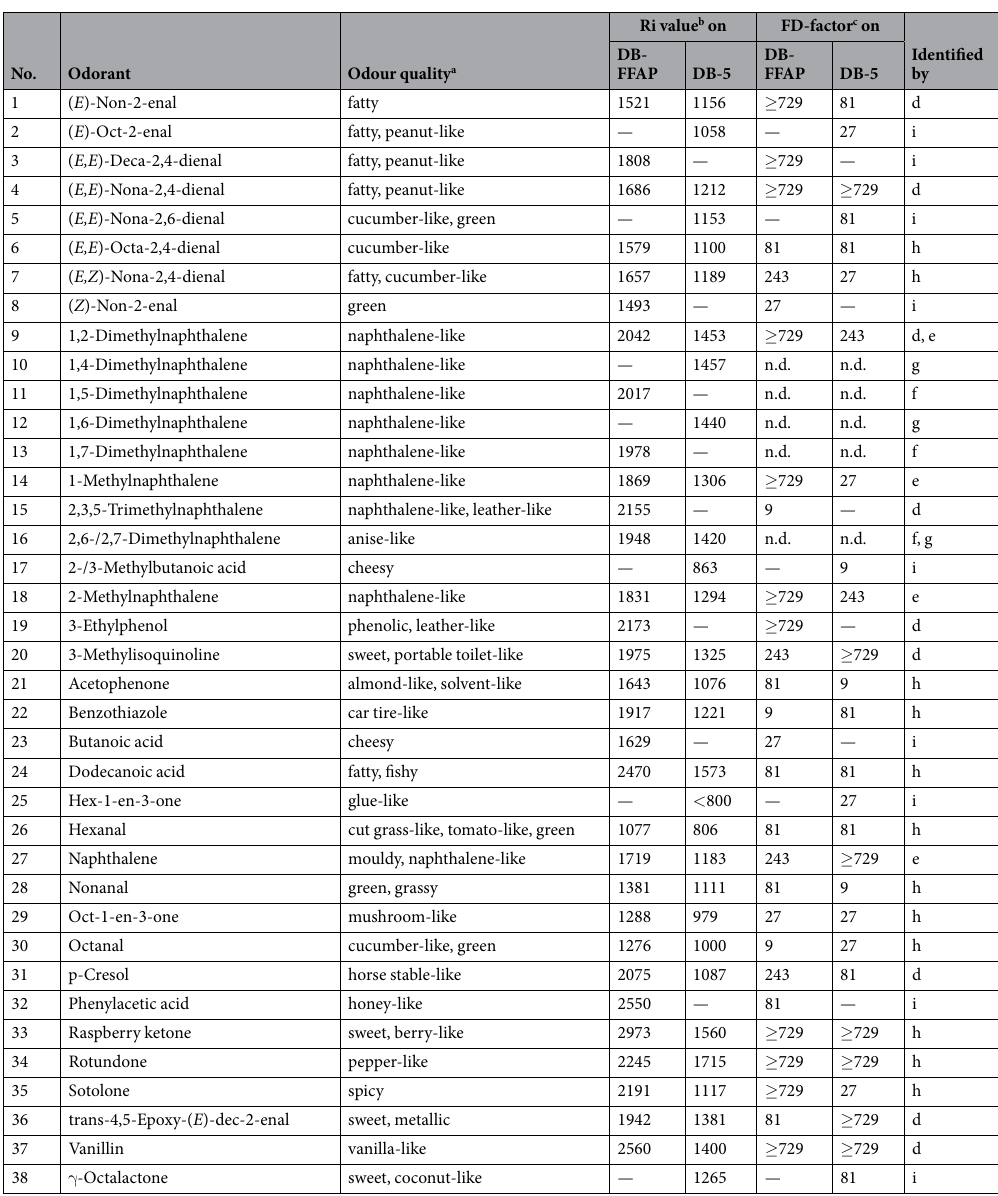
Table 1. List of all identified odorants in the sample by means of GC-O and their characteristics. a Odour quality perceived at the sniffing port during GC-O analysis. b Retention index on capillaries DB-FFAP and DB-5 according to 24 . c FD: determined flavour-dilution factor according to 25 . d The compound was identified by comparison of odour quality, retention index on both capillaries and mass spectrum (MS-EI), obtained by 2D-GC-MS/O analysis, with the properties of the reference compound. e The compound was identified by comparison of odour quality, retention index on capillary DB-FFAP and mass spectrum (MS-EI), obtained by GC-MS/O analysis, with the properties of the reference compound. f The compound was identified by comparison of retention index on capillary DB-FFAP and mass spectrum (MS-EI) only, obtained by GC- MS/O analysis, with the properties of the reference compound. g The compound was identified by comparison of retention index on capillary DB-5 and mass spectrum (MS-EI) only, obtained by GC-MS/O analysis, with the properties of the reference compound. h The compound was identified by comparison of odour quality and retention indices on capillaries DB-FFAP and DB-5. i Proposed structure by comparison of odour quality and retention index on capillaries DB-FFAP or DB-5. n.d. not